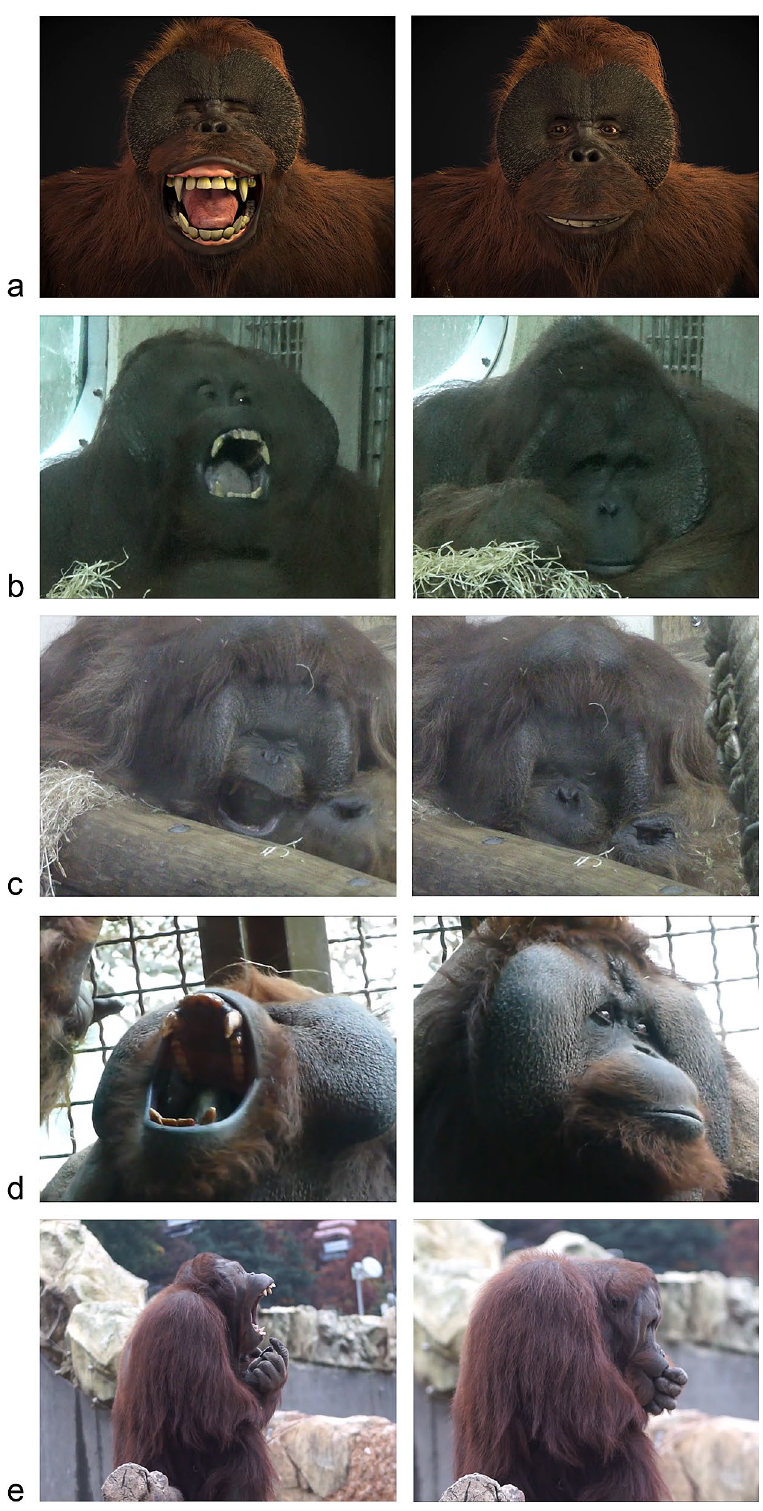
Figure 1. Stills of the videos used in the experiment with yawns on the left and controls on the right. A: Avatar* 68 , B: Familiar adult 1, C: Familiar adult 2, D: Unfamiliar adult 1 70 , E: Unfamiliar adult 2 71 . *To decrease the chances of pseudo-replication within this category we created horizontally mirrored copies of the yawn and control videos of the avatar such that – similar to the other triggers – we had two yawn and two control videos in